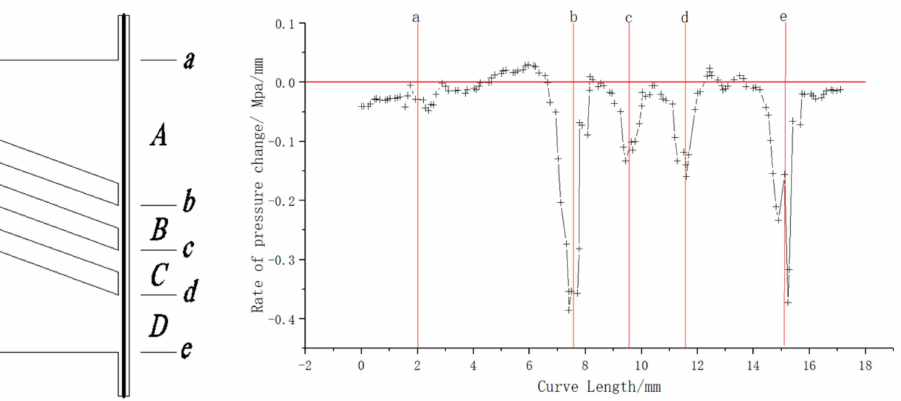
Figure 9. Pressure field and pressure curve.